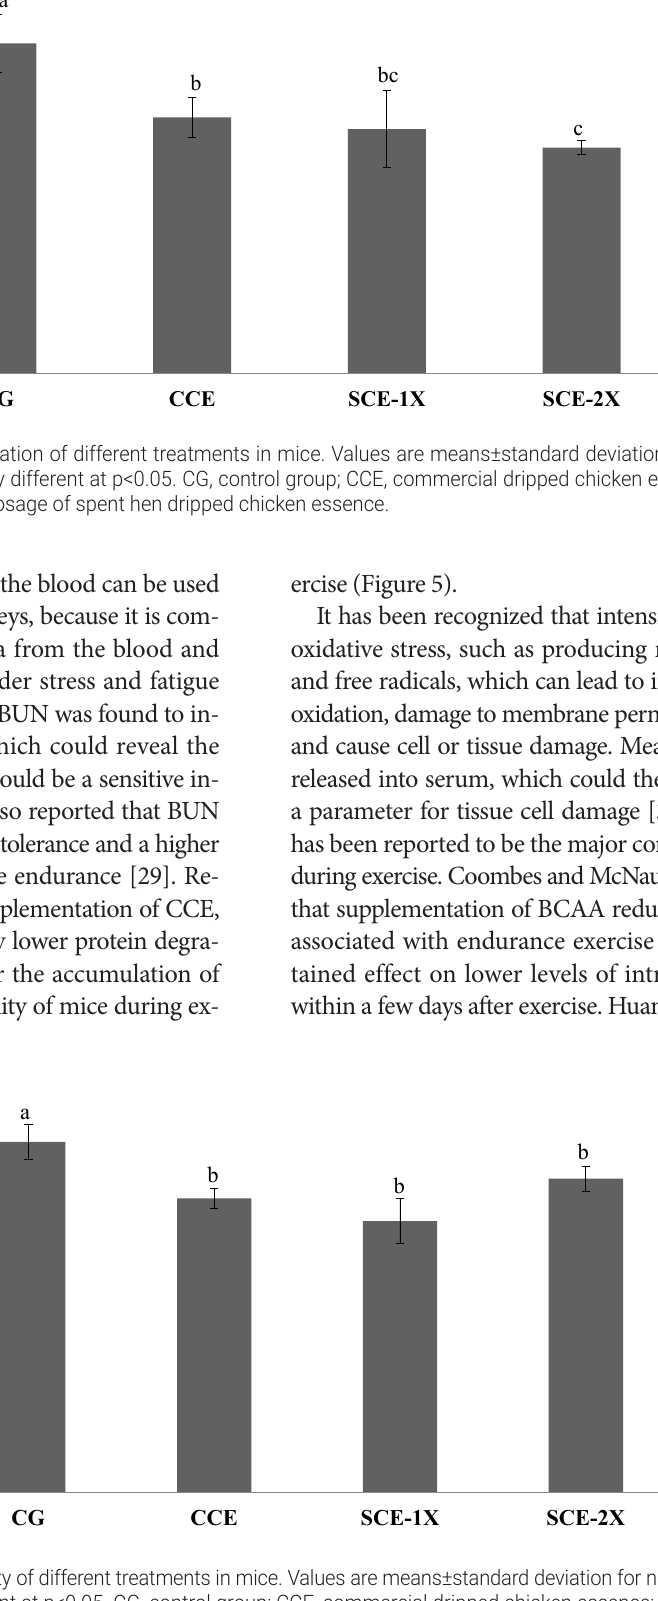
Figure 5. The creatine phosphokinase activity of different treatments in mice. Values are means±standard deviation for n = 8 mice per group. a,b Bars with different letters are significantly different at p<0.05. CG, control group; CCE, commercial dripped chicken essence; SCE-1X, spent hen dripped chicken essence; SCE-2X, double dosage of spent hen dripped chicken essence.